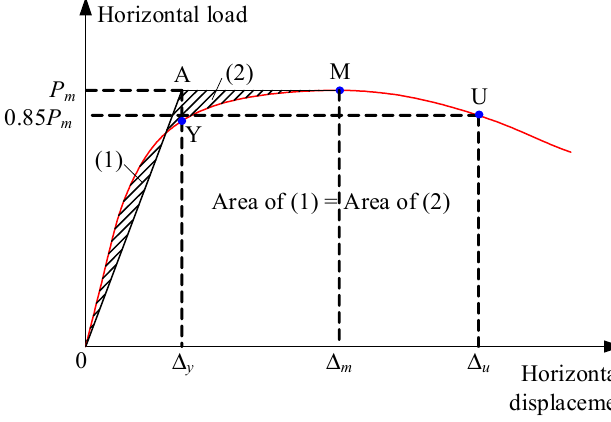
Figure 13. Equivalent yield point calculation diagram.